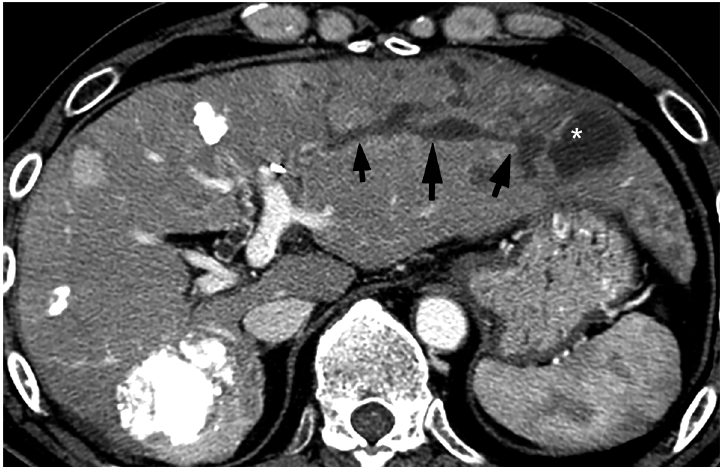
Figure 9. Portal phase image of contrast-enhanced CT of BDN and the biloma after transarterial therapy. A hypodense tubular structure (arrows) is connected to the large cystic lesion (*) in the lateral segment of the liver. The tubular structure is BDN of the anterolateral segment (S3) and the cystic lesion is biloma.